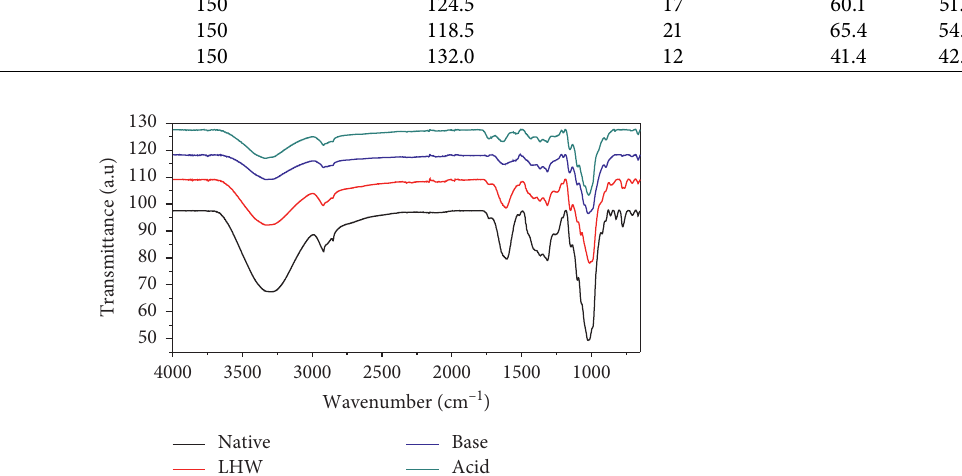
Figure 2: FTIR spectra of the banana pseudostem. , native (untreated); , LHW (liquid hot water); , base (3% NaOH); , acid (5% H 2 SO 4